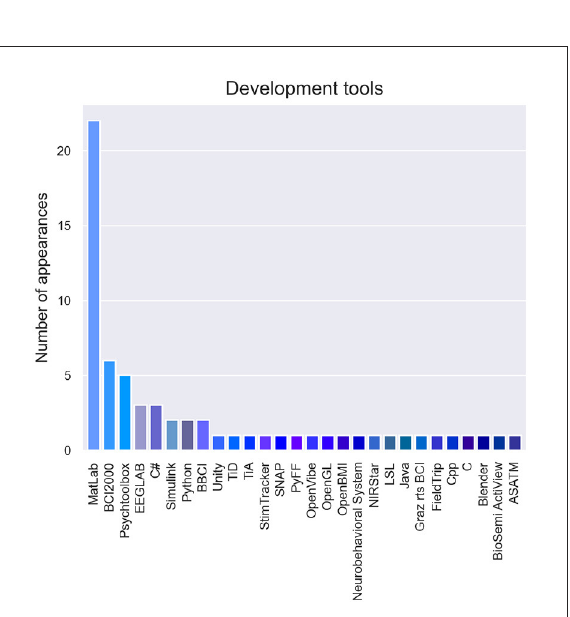
FIGURE7 Tools utilized for the development of hBCI